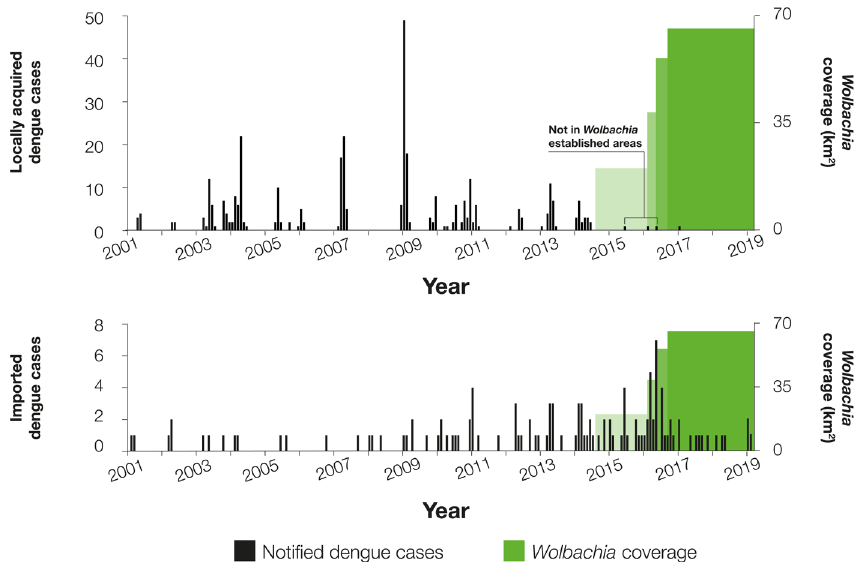
Figure 4. Dengue case notifications. Dengue case notifications per month in Townsville, Australia, January 2001 – March 2019, before and after Wolbachia mosquito deployments. Notifications include laboratory-confirmed and probable dengue cases, classified as locally- acquired ( A ) or imported ( B ) based on a history of overseas travel to a dengue-affected country during the period 3 – 12 days prior to illness onset. Data was extracted from the Queensland Health Notifiable Conditions System (NOCS) on 11 April 2019. Green shading shows the